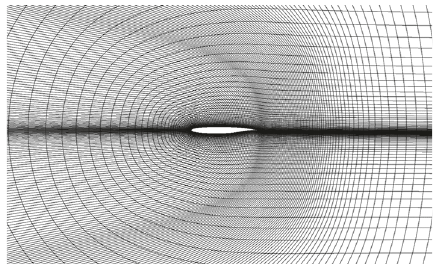
Figure 13: Far-field of the Navier–Stokes mesh optimized with curvature control functions but without orthogonality functions, showing the impact of curvature functions when compared to Figure 11(a).